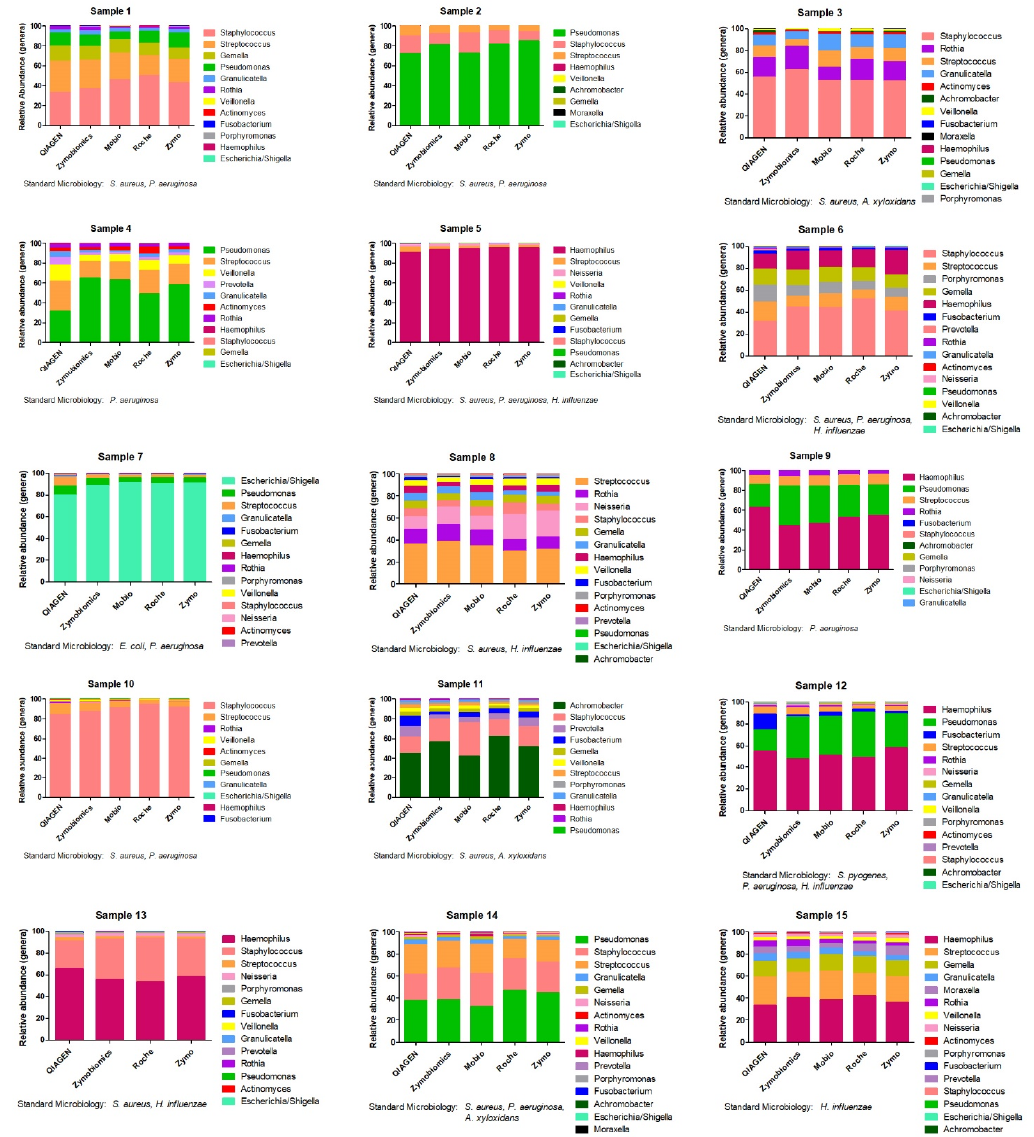
Figure 6. Genera-relative abundances of 15 patients for each of the considered methods (Experiment 3).